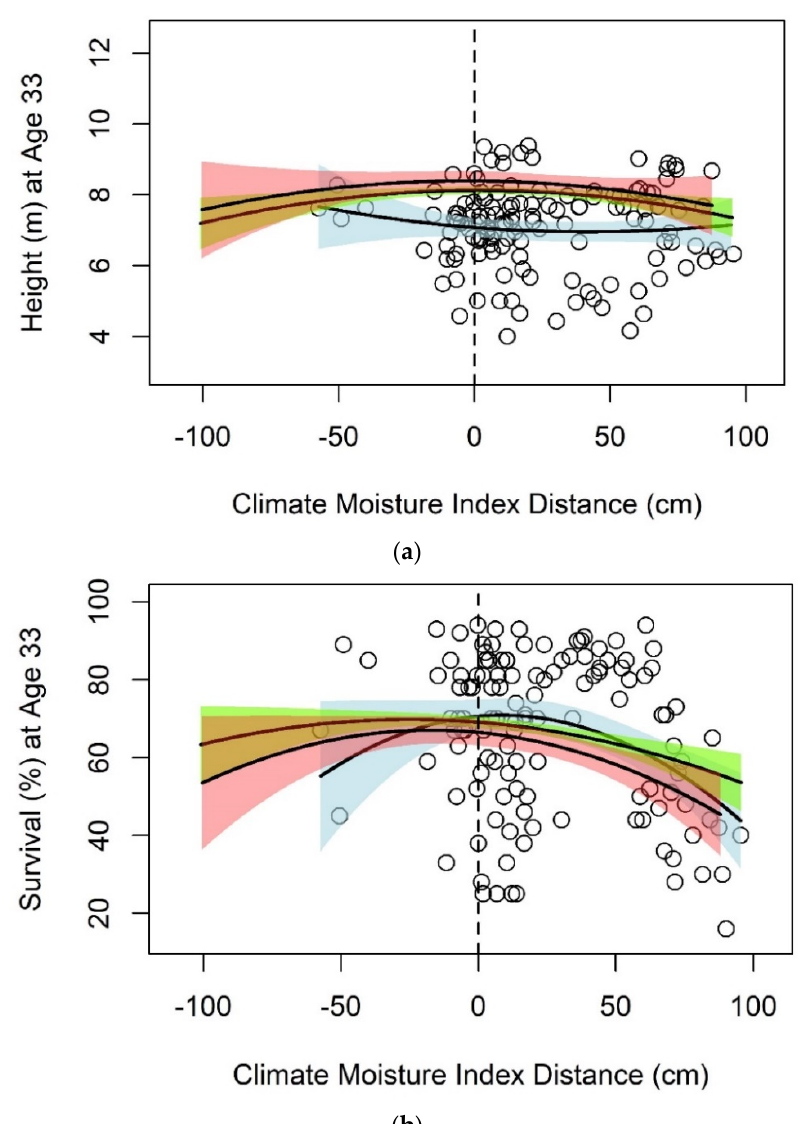
Figure 4. Relationship between climate moisture index transfer distance and ( a ) height and ( b ) survival of black spruce seed sources at 33 years of age. Separate regression lines and 95% confidence intervals are shown for southern (red), central (green), and northern (blue) seed sources. Data points